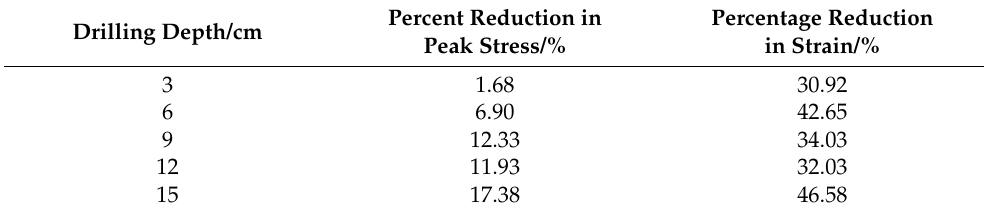
Figure 3. ( a ) is the peak strength of the test block under different hole depths, and ( b ) is the stress–strain and pre-peak cumulative strain energy curve. Table 3. Peak intensity and strain value decrease by percentage at peak intensity.